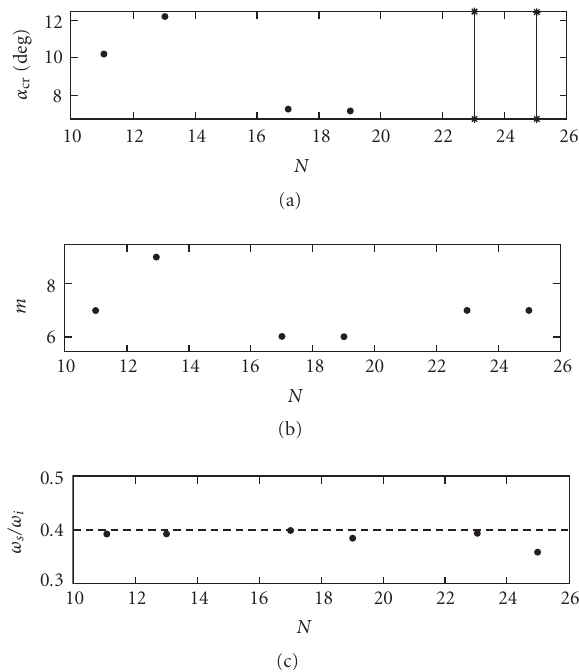
Figure 7: (a) The critical flow angle, (b) number of rotating cells, and (c) their relative propagation speed versus the number of im- peller blades N .